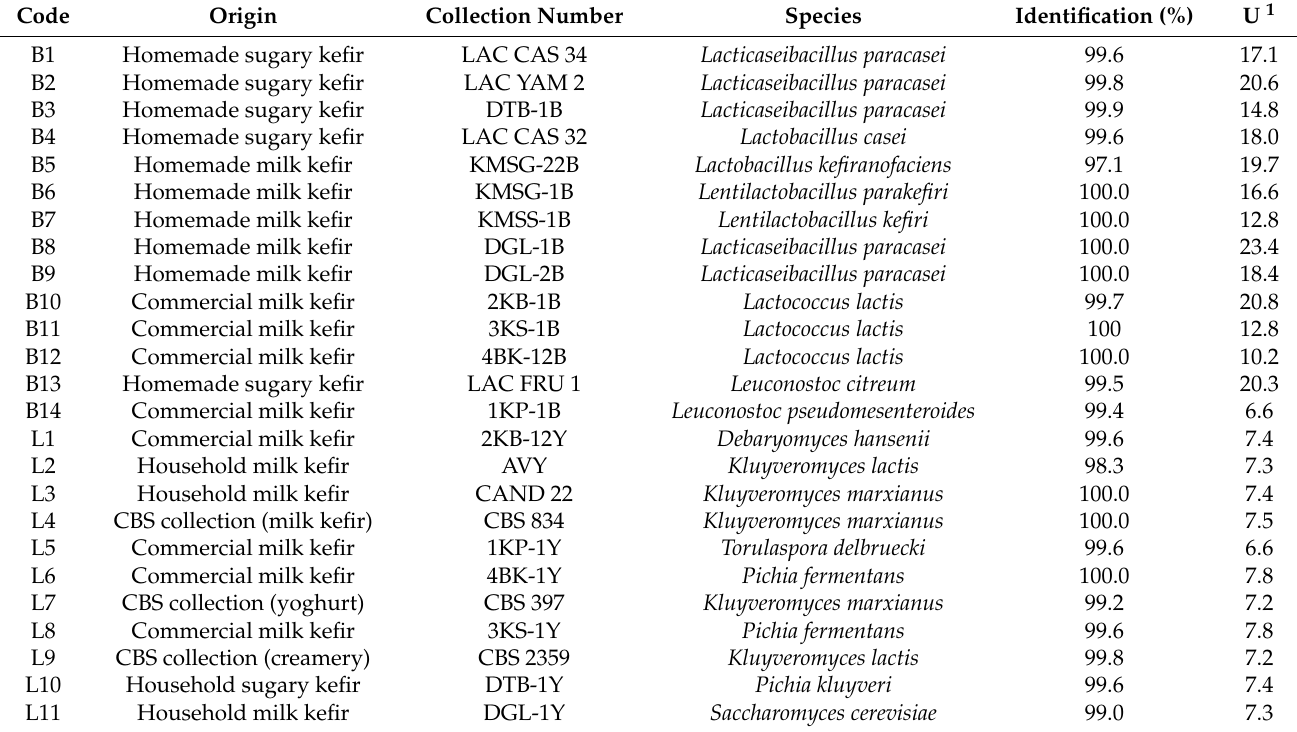
Table 1. List of the microbial strains used in this work and relative phytase